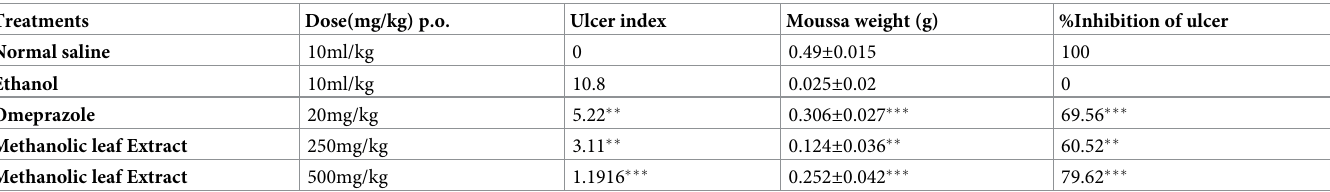
Table 10. Effect of different methanolic extracts E . spinosa on gastric ulcer, pH, total acidity in chronic aspirin-induced gastric ulcer. Treatments